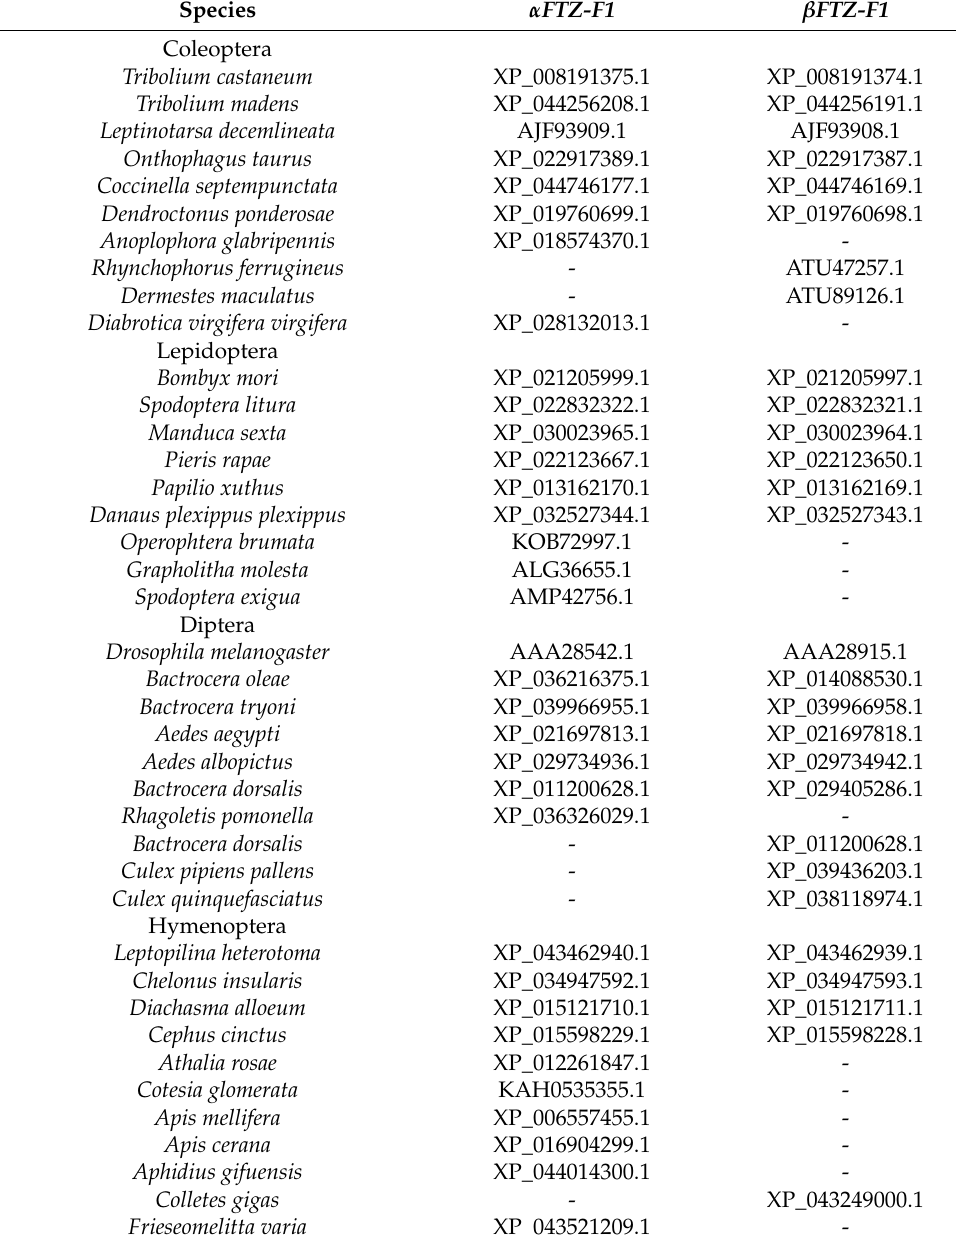
Table 1. Sequences used in gene structure